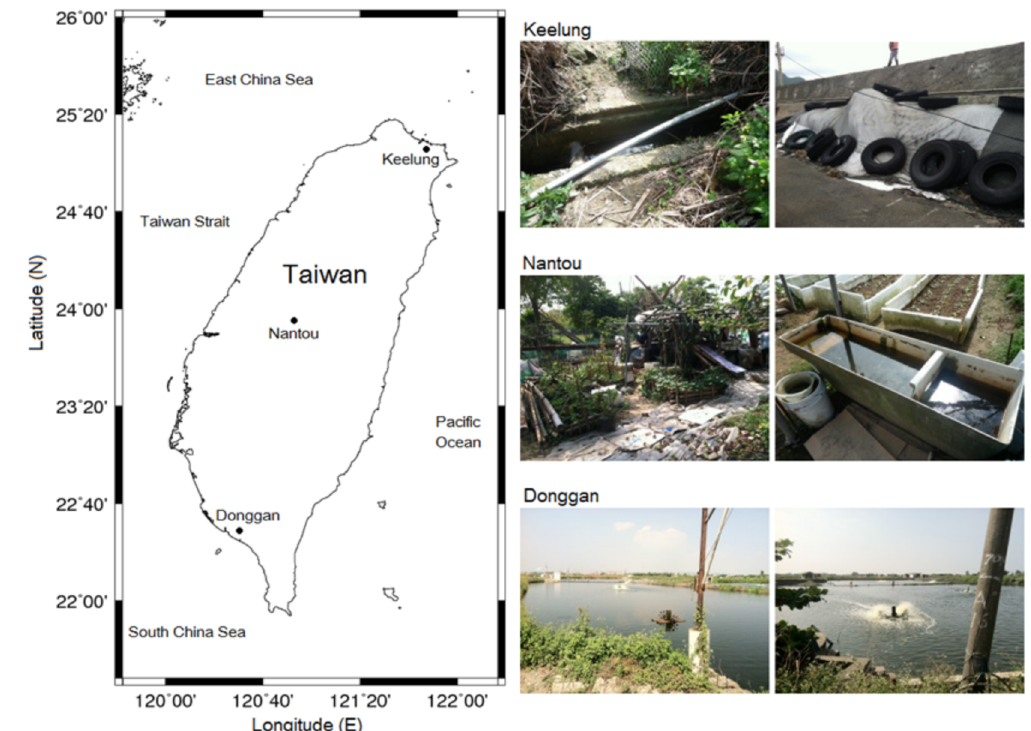
Figure 1. Map showing the field sample collection and study areas in